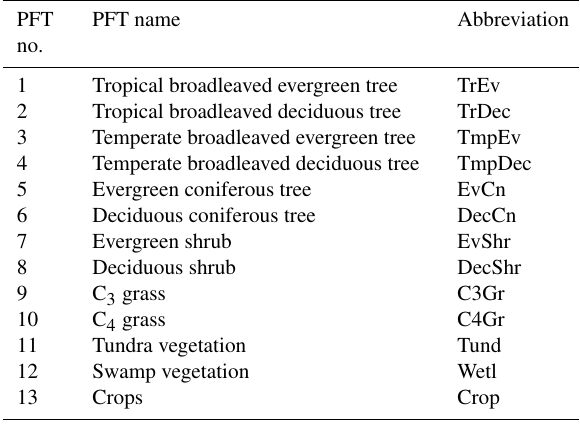
Table 1. PFTs defined in BETHY and their